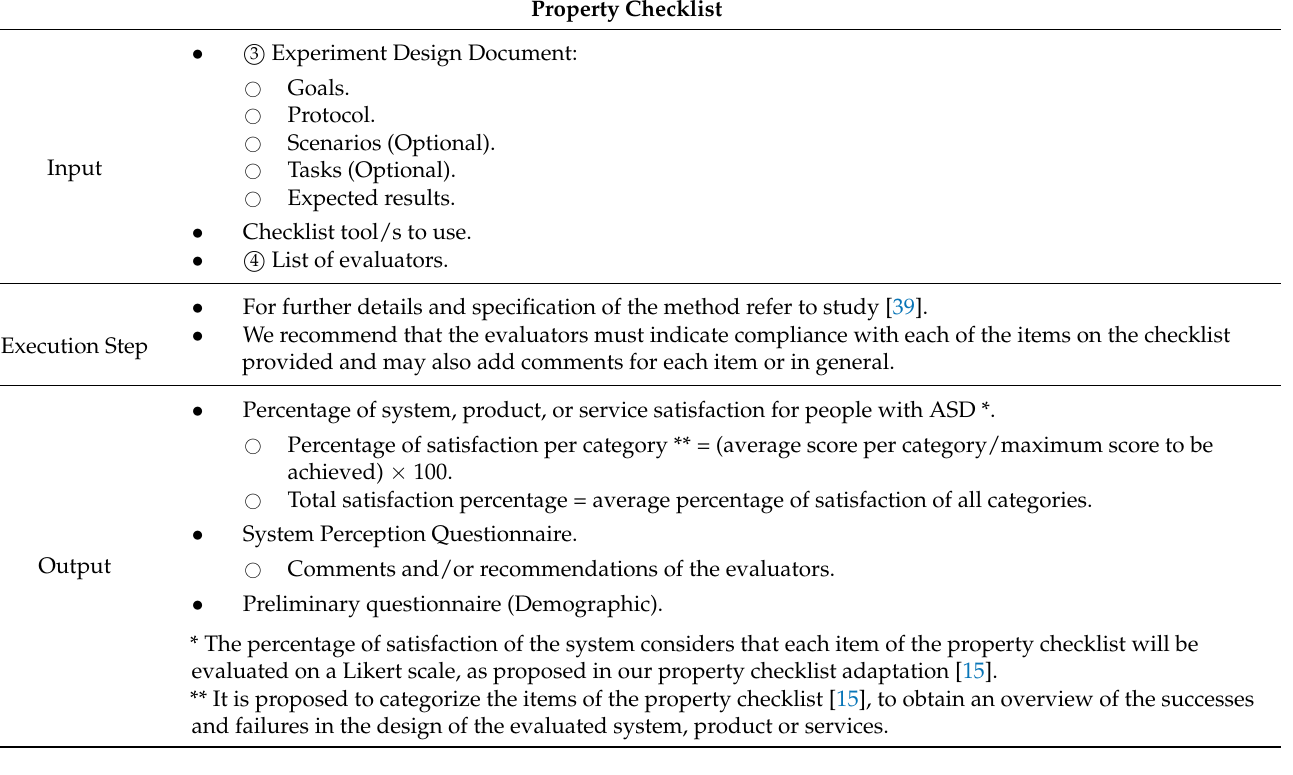
Table A9. Group-Based Expert Walkthrough Specification. Group-Based Expert